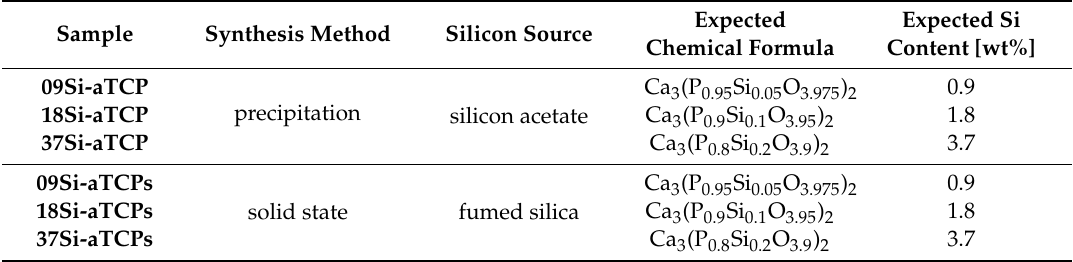
Table 3. Designation and nominal composition of Si- α TCP